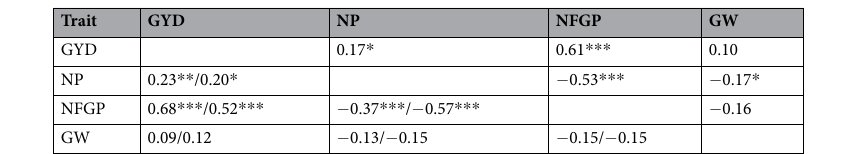
Table 2. Phenotypic and genotypic correlations for four yield traits. The up-triangle are genotypic correlation coefficients estimated by predicted genotypic values; the first and the second values in the low-triangle are phenotypic correlation coefficients for the environment 1 (Hangzhou) and 2 (Lingshui), respectively; * , ** , *** indicate the significant level of 0.05, 0.01 and 0.005; GYD = grain yield, NP = number of panicles per plant, NFGP = number of filled grains per panicle, GW = grain